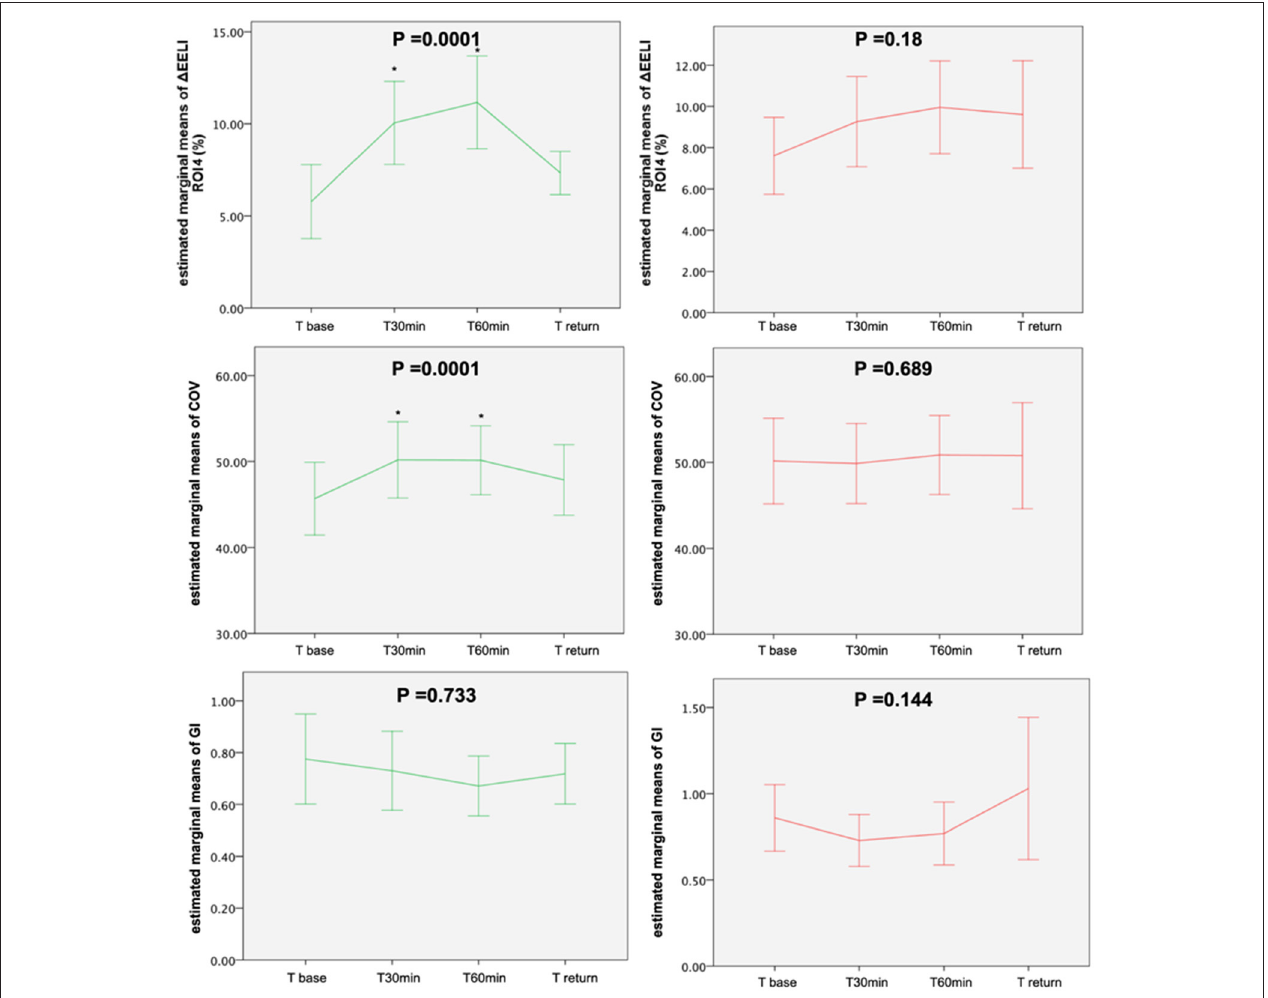
FIGURE 3 | Evolution of the estimated marginal means of ROI 1–4, GI and COV at different time points in two subgroups. GI, global inhomogeneity; COV, center of ventilation; DVI, dorsal-ventilation improved group; Non-DVI, dorsal-ventilation not-improved group. The green line indicates the DVI group and the red line indicates the non-DVI group. p value by general linear model repeated measures. * p < 0.05 indicates a significant difference between this time point and T base